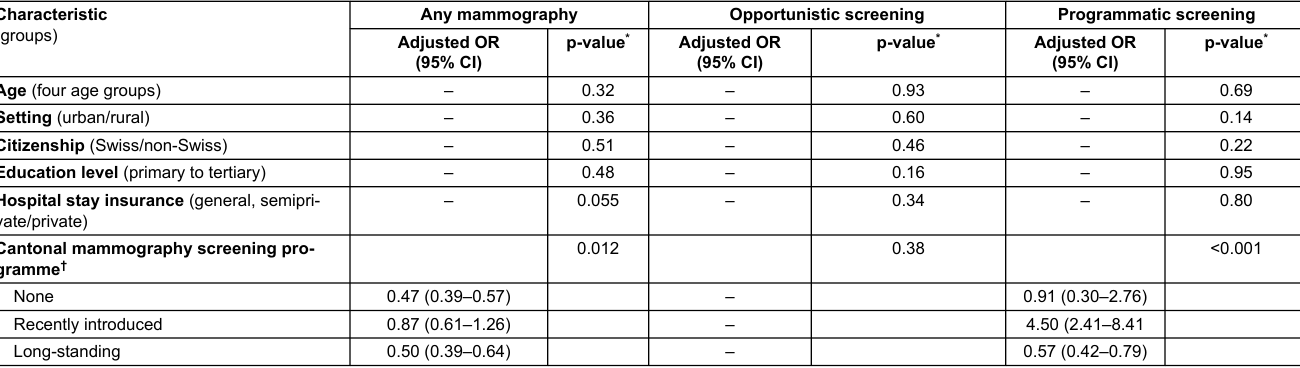
Table S1: Factors associated with the temporal change in self-reported mammography in the last 12 months in women (age 40 to 79 years) in Switzerland, 2007 and